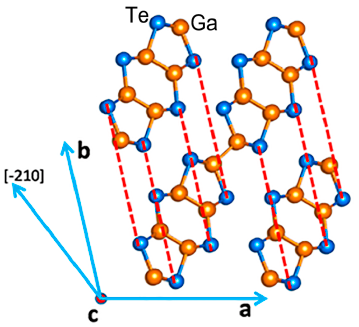
Figure 4. The stacking direction of the layers in GaTe crystal structure.